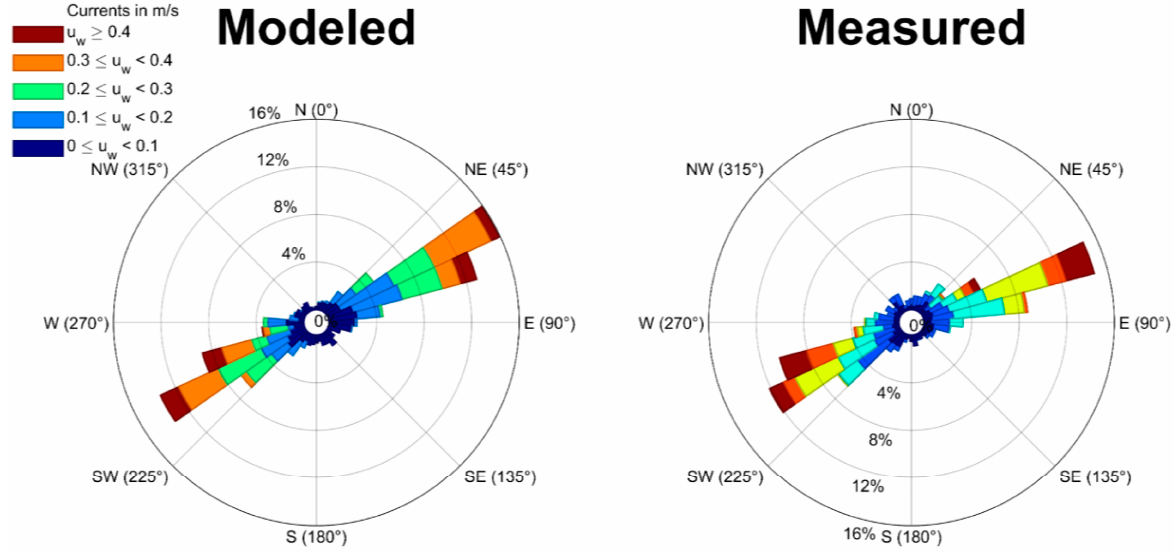
Figure 6. Currents roses comparison for simulations and measurements for the calibration period.